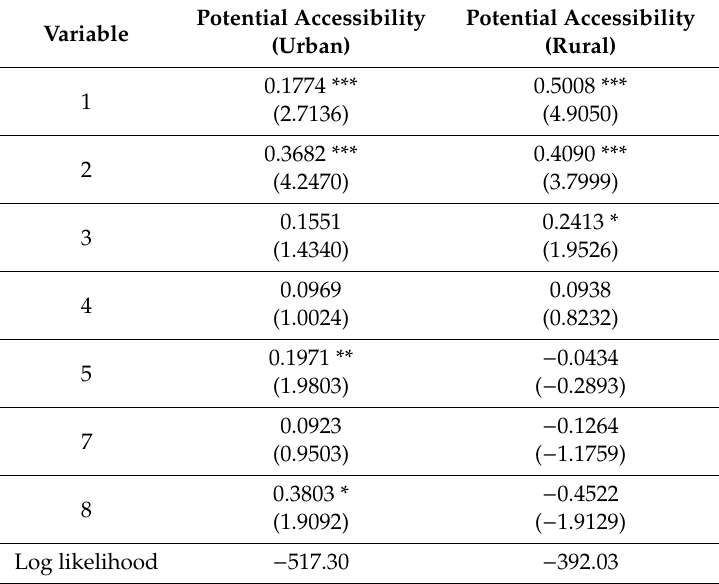
Table 6. The impact of residence on potential